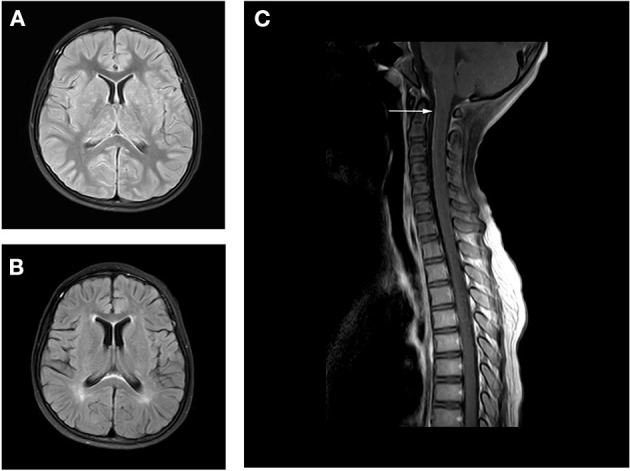
Axial fluid attenuation inversion recovery (FLAIR) MRI brain (A) upon admission and (B) 2 months later. Image (A) showed T2-hyperintense lesions in in bilateral thalamus and basal ganglia. Follow-up image (B) showed improved T2 lesions. MRI of the spine (C) 10 days after admission showed leptomeningeal enhancement in the cervical cord.